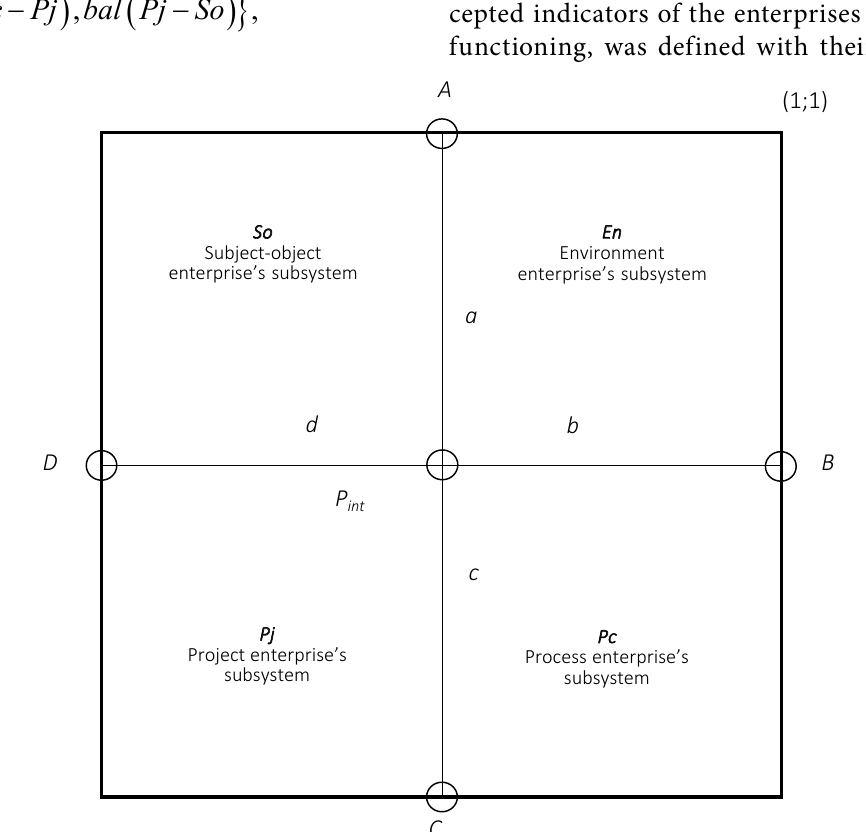
Figure 1. Graphical model of the ideal configuration of the enterprise system balanced